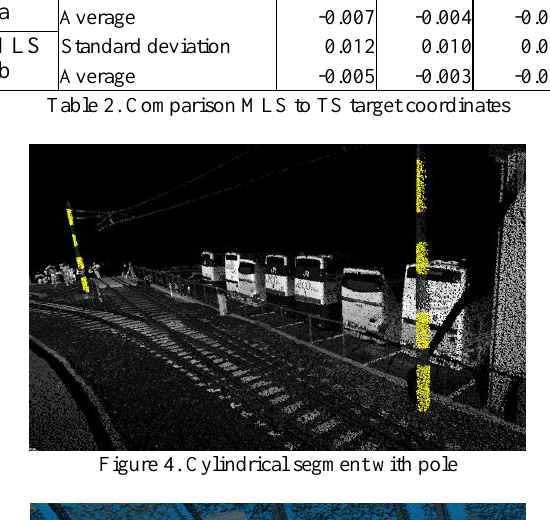
Figure 4. Cylindrical segment with pole